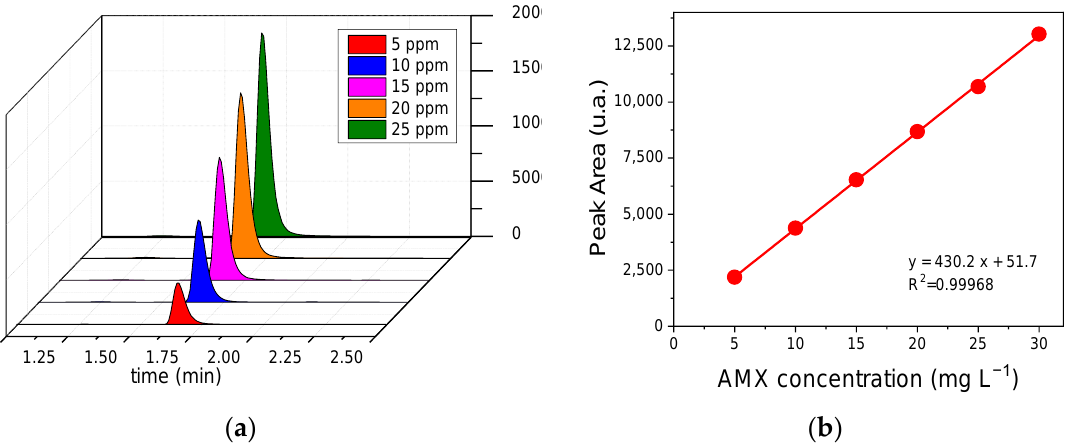
with R 2 of 0.9996; the limits of detection (LOD) and quantification (LOQ), defined as LOD = 3 × SD/slope and LOQ = 10 × SD/slope, obtained from the calibration curve were 0.147 and 0.491 mg L − 1 , respectively (Figure 7b) [49]. For the LOD and LOQ equations, SD (lowest concentration) is the standard deviation of the (above) baseline noise, which is typically three times the noise level; and LOQ is defined as the lowest amount of analysis that can be reproducibly quantified above the baseline noise [50].